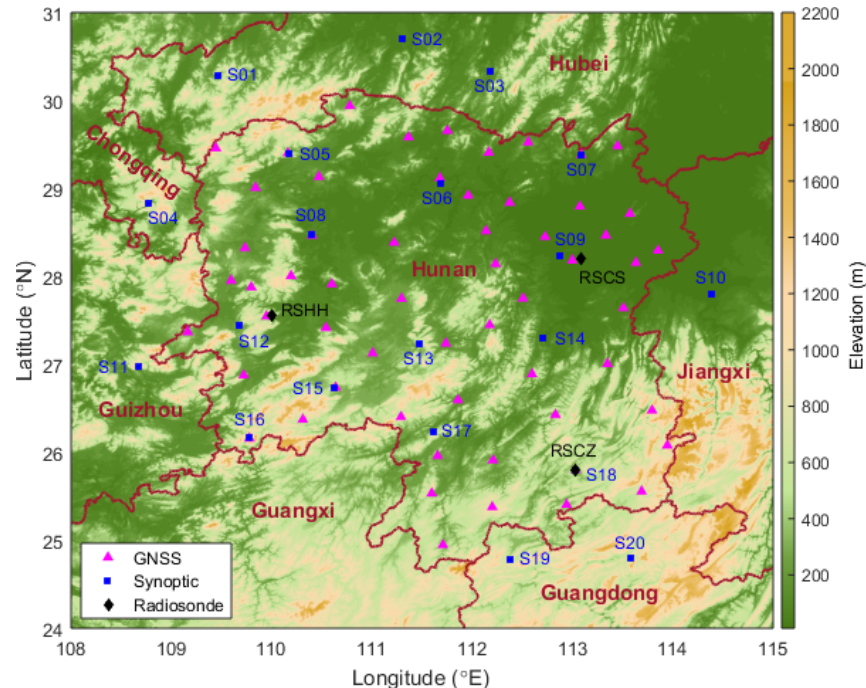
Figure 1. Geographic distribution of GNSS, synoptic and radiosonde stations in Hunan and surrounding